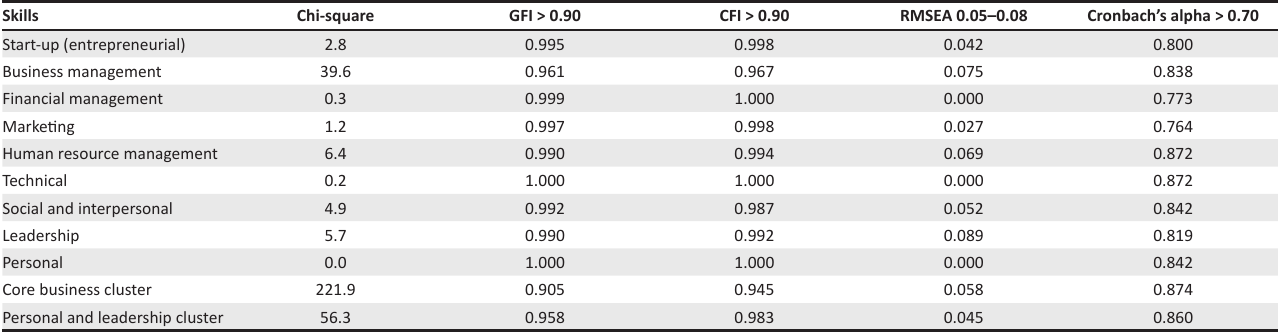
TABLE 4: Confirmatory factor analysis. Skills